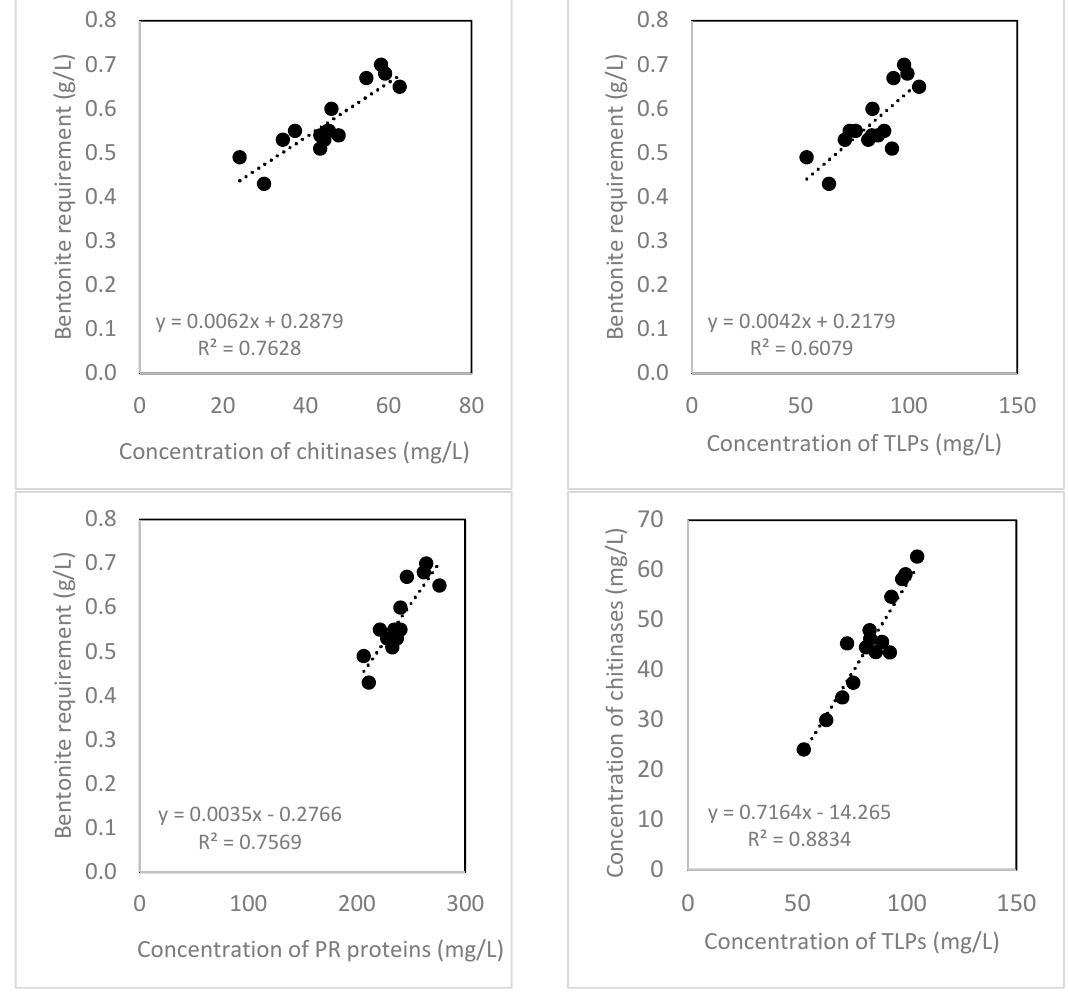
Figure 1. Correlations between bentonite requirement and the concentration of chitinases, TLPs and PR proteins in wines from 2012DP.